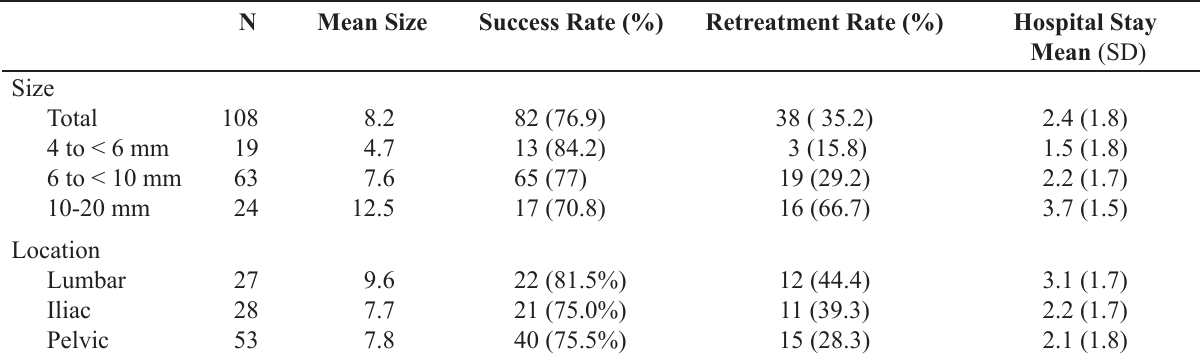
Table 2 – Results of ESWL at 3 months as a function of stone location and size. N �ean